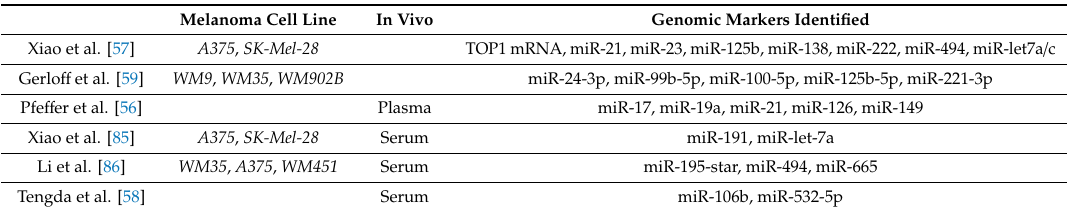
Table 3. Summary of studies describing potential melanoma-derived EV genomic